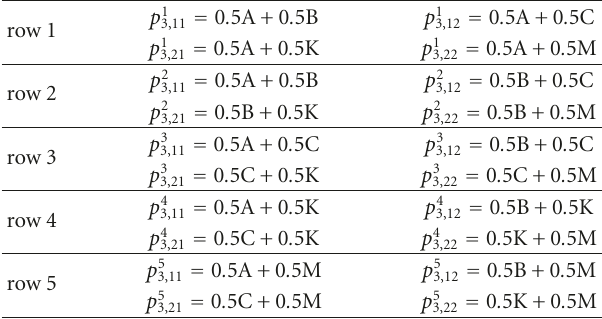
Table 1: Mixed panel pixels in the 3rd column for simulations.